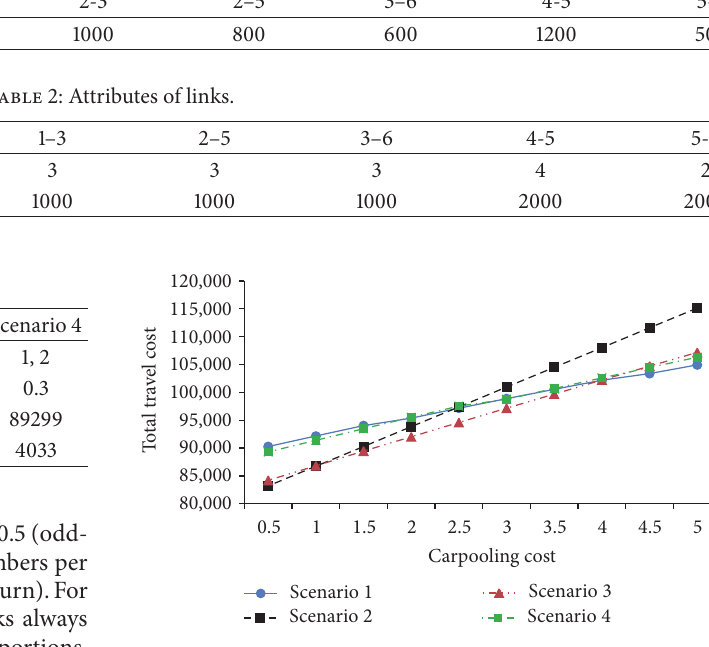
Figure 2: The total travel costs with various carpooling costs.